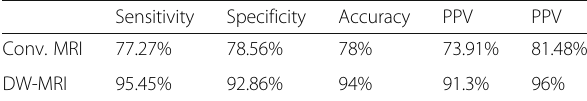
Table 5 Validity of conventional MRI/DW-MRI in the diagnosis of all studied endometrial lesions ( n =